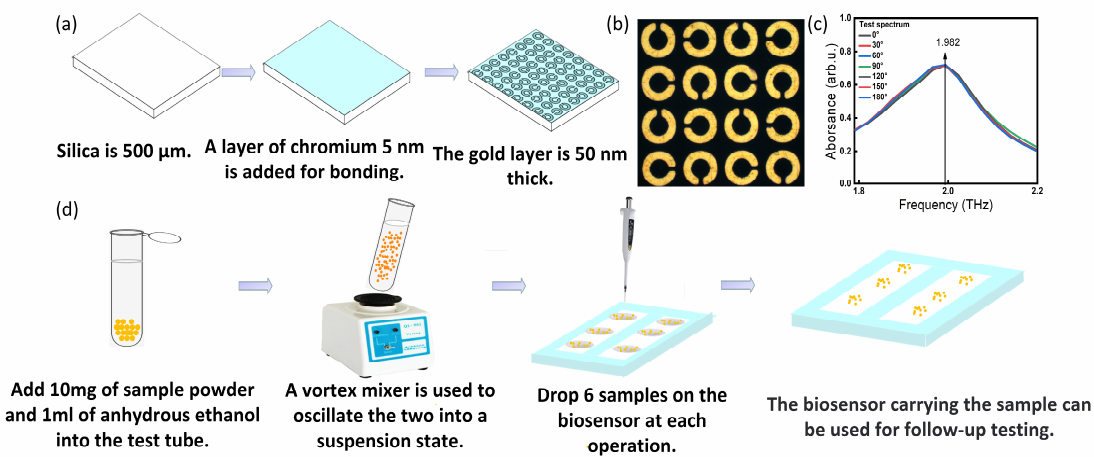
Figure 5. ( a ) Schematic diagram of THz SPR biosensor processing. ( b ) Microscope image of SPR biosensor structure. ( c ) Experimental response spectra of the THz SPR biosensor. ( d ) Schematic diagram of sample preparation process before test.3.5. Data Processing and Analysis.